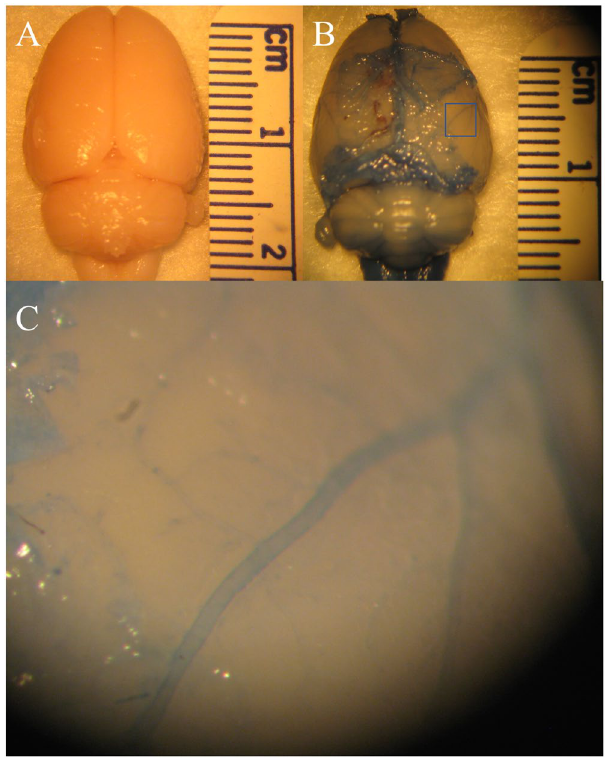
Figure 1. Perivascular uptake of the tracer visualized in brightfield images obtained using a dissection microscope eyepiece camera. ( A ) Naïve rat brain, ( B ) Rat brain with Gd-Alb-EB infused into the lateral ventricle with attached dura. ( C ) Magnified view of the blue rectangular region of interest drawn in ( B ) showing perivascular tracer labeling along cortical blood vessels of a tracer-infused